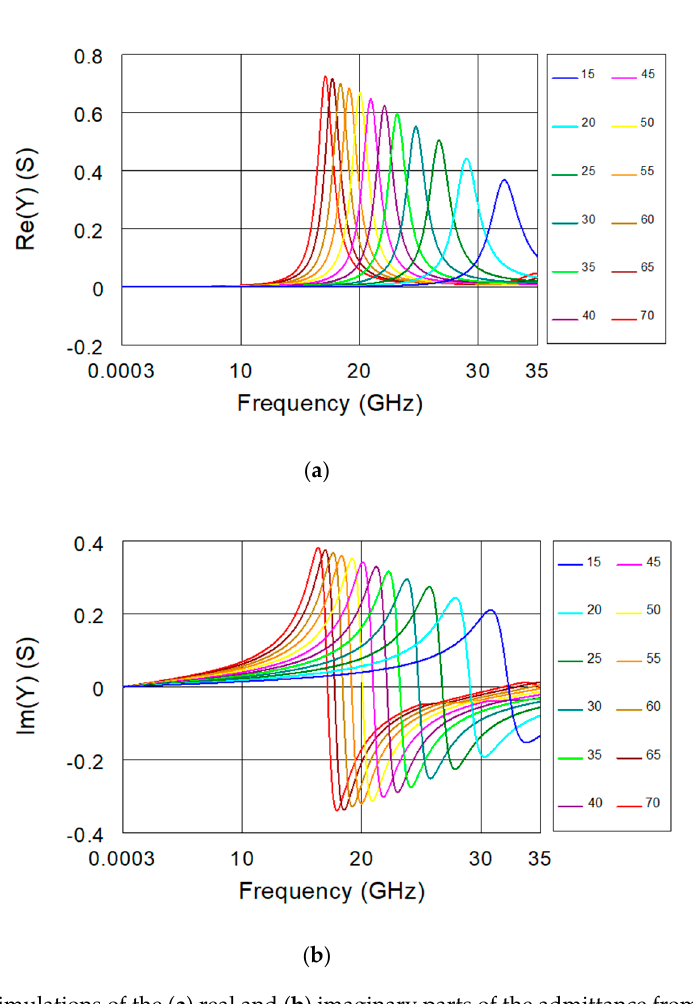
Figure 3. FEM simulations of the ( a ) real and ( b ) imaginary parts of the admittance from 0.3 MHz to 35 GHz for the IDC sensor loaded with lossless MUTs having a real part of the relative permittivity varied from 15 to 70 with a step of 5.